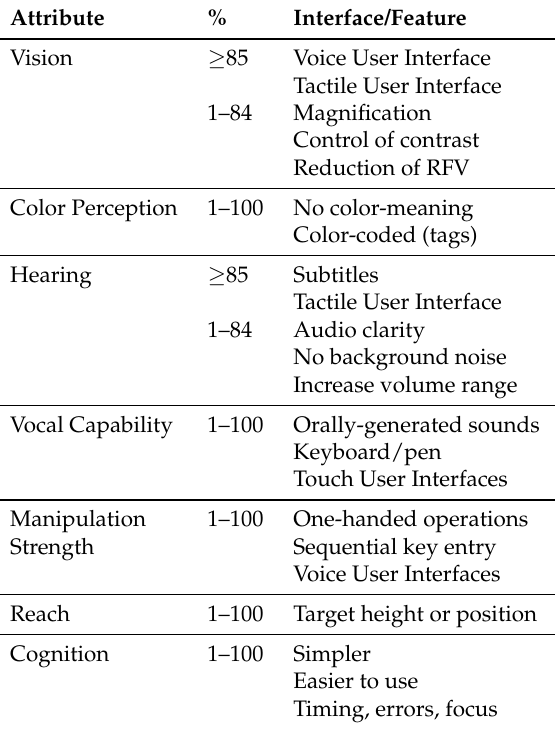
Table 3. Functional